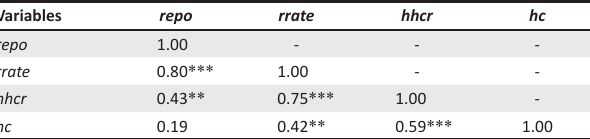
TABLE 4-A1: Correlation matrix (1994Q1–1999Q4). TABLE 5-A1: Correlation matrix